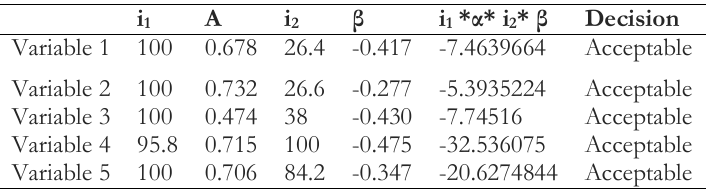
Table 15. Decision matrix evaluating the consistency of the items in terms of agreement and disagreement items of the neutrosophic